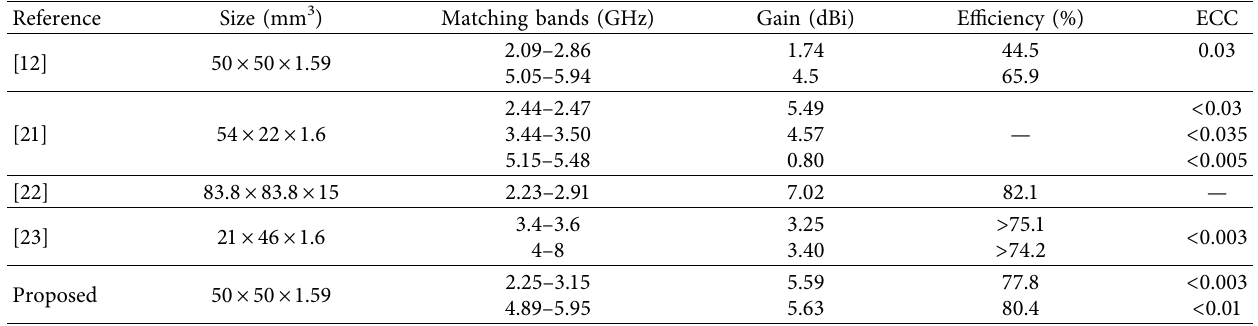
Table 2: Comparison between the proposed MIMO antenna and other reported